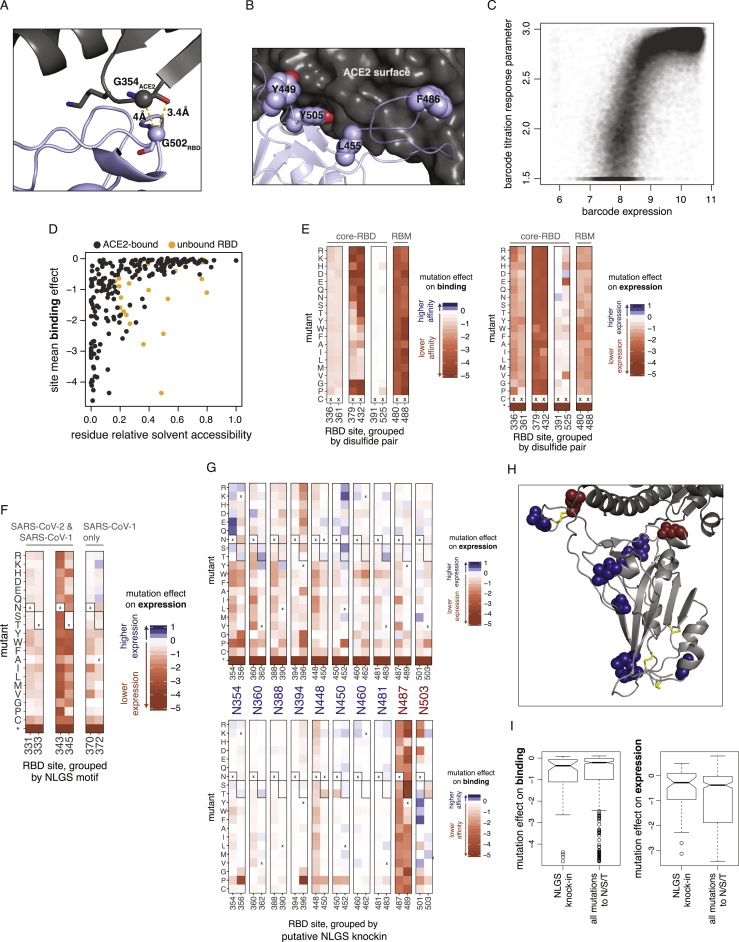
Additional Structural Analyses of Mutation Effects, Related to Figure 5(A, B) Structural depictions of sites exhibiting stability-binding tradeoffs. (A) RBD residue G502 requires small amino acid side chains for ACE2 binding (Figure 3B), consistent with its close proximity to G354ACE2 in the bound structure. (B) Mutations to polar residues at positions Y449, L455, F486, and Y505 would enhance expression but reduce binding, consistent with specific geometric constraints imposed by the close packing of these residues at the ACE2 surface. (C) Relationship between barcode expression and titration response plateau parameters. The correlation between mutation effects on binding and expression in Figure 5C could emerge from trivial correlation between phenotypes (e.g., yeast with higher RBD surface expression can bind more ACE2). However, our multiple-concentration titration approach should in principle remove this trivial correlation (Adams et al., 2016), because each binding phenotype is determined from a self-referenced titration curve, for which the free plateau response parameter can vary to account for different levels of saturated binding due to RBD expression (see Figure S2D). Consistent with this premise, the response parameter from the titration fit for library variants with KD,app < 10−7 (as lower-affinity titration curves do not adequately sample the titration plateau) correlates with its expression phenotype. (D) Relationship between mutational constraint on binding and residue relative solvent accessibility (RSA). Black dots indicate RSA in the full ACE2-bound RBD structure, and when sites have changes in RSA in the unbound structure, then their RSA in that structure is also shown in orange. (E) Mutation effects on binding (left) and expression (right) at disulfide cysteine residues. Details as in Figure 3. RBD sites are grouped by disulfide pair and labeled according to location in the core-RBD or RBM sub-domains. (F) Mutation effects on expression at N-linked glycosylation sites (NLGS). RBD sites are grouped by NLGS motif (NxS/T, where x is any amino acid except proline). Boxed amino acids indicate those that encode a NLGS motif. NLGS motifs are labeled according to whether they are present in both the SARS-CoV-2 and SARS-CoV-1 RBD (N331 and N343 glycans), or in SARS-CoV-1 only (N370 glycan). Introduction of the N370 glycan in SARS-CoV-2 is mildly deleterious for stability. (G) Effects of putative N-linked glycosylation site (NLGS) knock-in mutations. Heatmap details as in Figure 3. There are 10 surface-exposed asparagines for which RBD expression is unaffected or enhanced (top) when an NLGS motif is introduced via mutations to S or T at the i+2 site; for eight of these putative NLGS knock-ins (blue labels), the putative glycan is also tolerated for ACE2 binding (bottom), but for two (red labels), introduction of the NLGS motif is not tolerated for ACE2 binding. (H) Mapping of these ten asparagines to the RBD structure illustrates that these two binding-constrained asparagines (red) map to the ACE2 interface. (I) For mutation effects on expression (left) and binding (right), comparison of phenotypic impacts of mutations that knock in new NLGS motifs (NxS/T) versus single mutations to N, S, or T at all positions. There is no trend for NLGS knockin mutations to be more deleterious than typical mutations to N, S, or T.